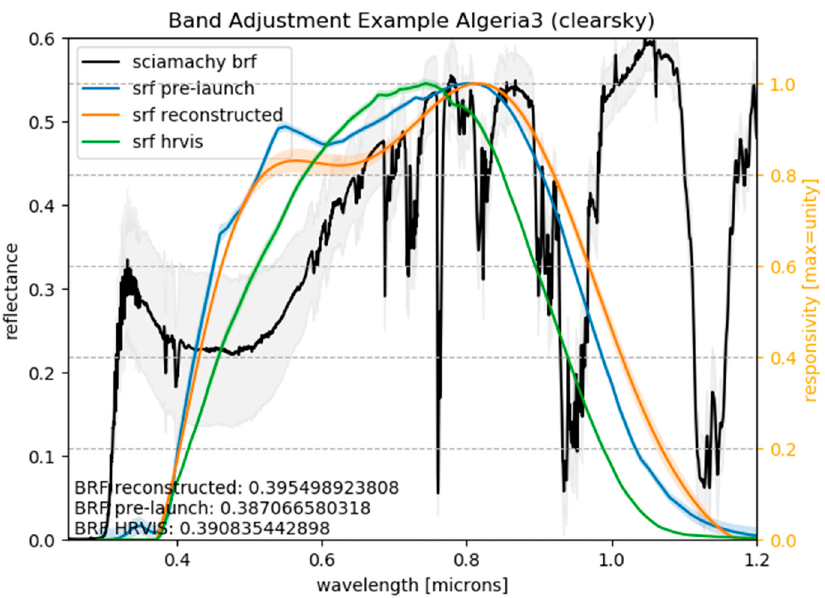
Figure 4. Mean SCIAMACHY spectrum collected above the Algeria-3 validation site along with the spectral response functions of the VIS channel on Meteosat-7 and the HRVIS channel on MSG1.